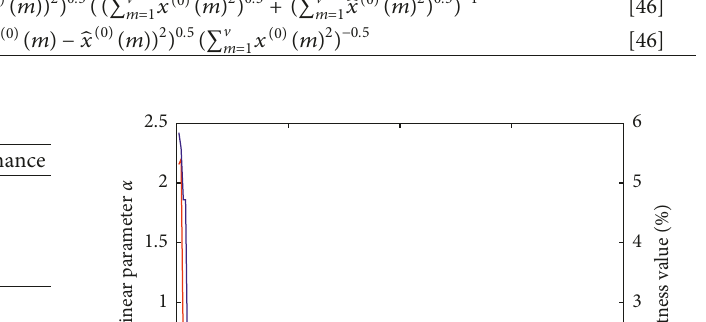
Table 4: The original data of China’s natural gas consumption (NGC) (2005–2015).